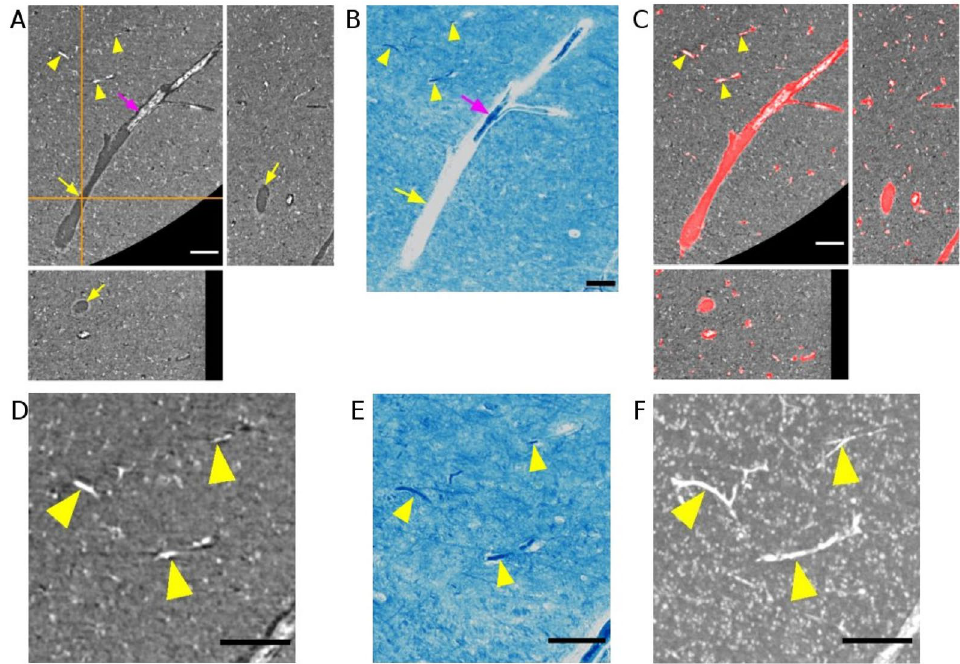
Figure 1. Validation of vessels found in phase-contrast microtomography by comparing with histology. ( A ) Orthogonal views of a blood vessel in a 0.94 µm voxel size microtomography image. The orange cross-hair indicates the location of the selected orthogonal planes. The vessel is characterized both by hyperintense parts with collapsed blood vessel (magenta arrow) and hypointense parts with voids (yellow arrow). ( B ) Microscope image of an approximately matching region of the same sample. The section is 10 µm thick and was stained with the Klüver-Barrera technique. ( C ) Binary vessel mask (red) obtained with the proposed segmentation method is overlayed on the image shown in A. Note that capillaries are well segmented (yellow arrowheads). ( D ) Zoomed inset of A. ( E ) Zoomed inset of B. ( F ) Maximum intensity projection of the inset region shown in D across 28 µm depth, showing an extended trajectory of the capillaries. Scale bars = 100